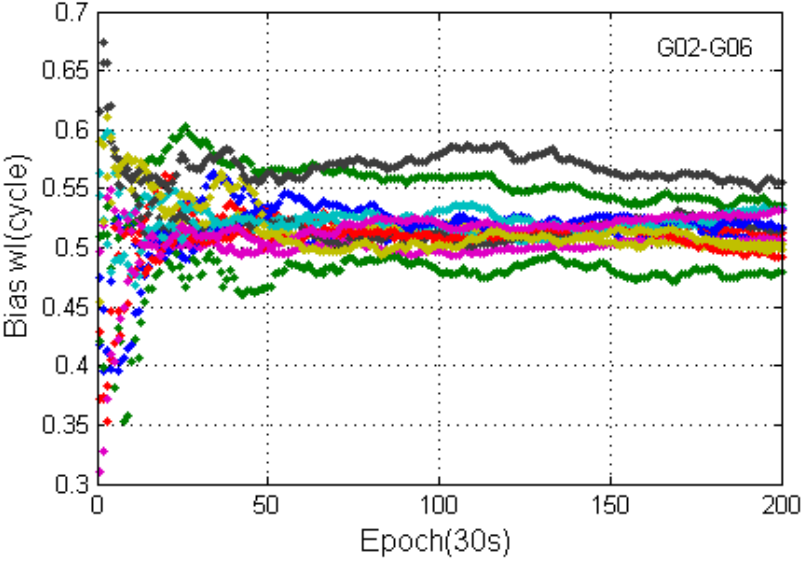
Figure 3. The fractional values of the wide lane ambiguity of G06 (reference satellite G02) at different stations.